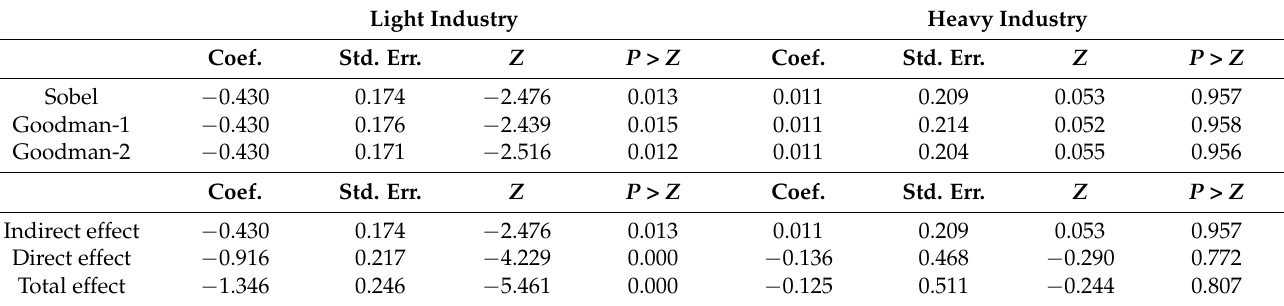
Table 6. Mediating effect test based on sub-samples of light and heavy industries. Light Industry Heavy